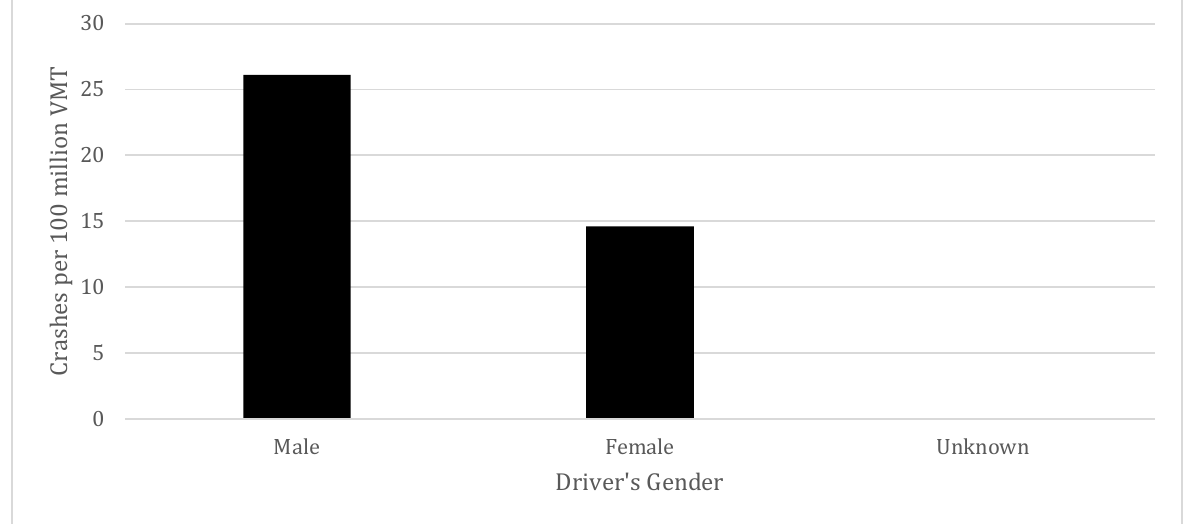
Figure 5 (a): Rate of animal-vehicle crashes based on driver’s gender